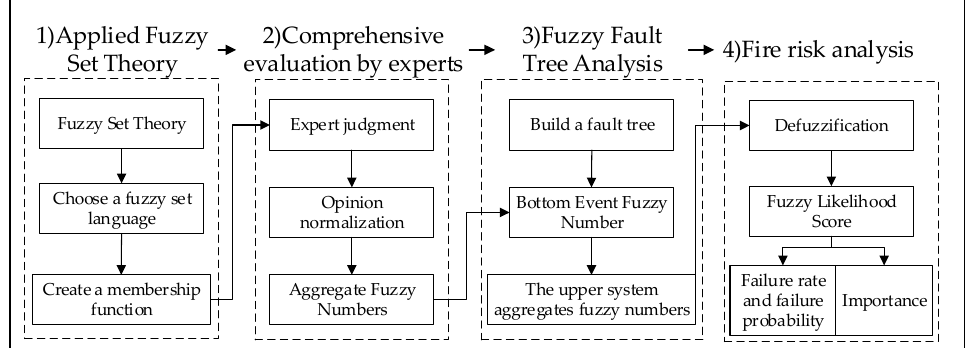
Figure 1. Calculation flow chart based on FFTA ‐ ECE evaluation method.